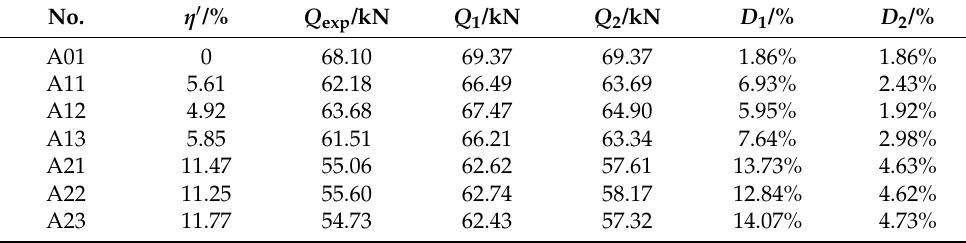
Figure 16. Finite element mesh division. Table 6. Comparison between the experimental results and numerical simulation results.